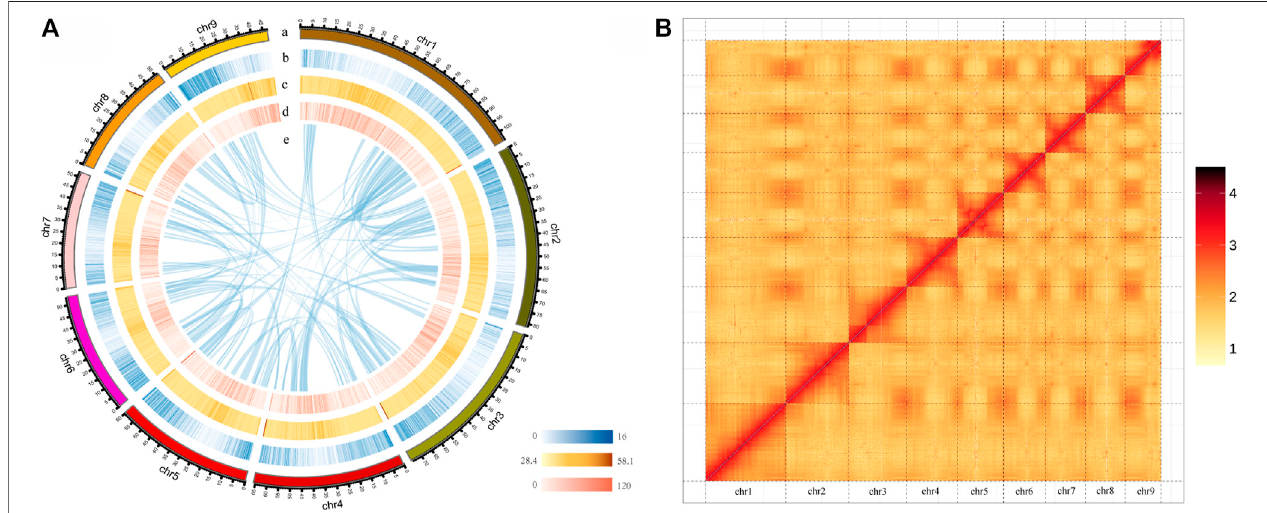
FIGURE 1 | Overview ofchromosome-level Platycodon grandi fl orus genome assembly. (A) P. grandi fl orus genomic features. Track a is the circular representation of nine pseudochromosomes. Track b-d represents the distribution of gene density, GC density, and repeat density, respectively, with densities calculated in 100 kb windows. Track e shows syntenic blocks identi fi ed within P. grandi fl orus genome. (B) Hi-C interaction heatmap for the P. grandi fl orus